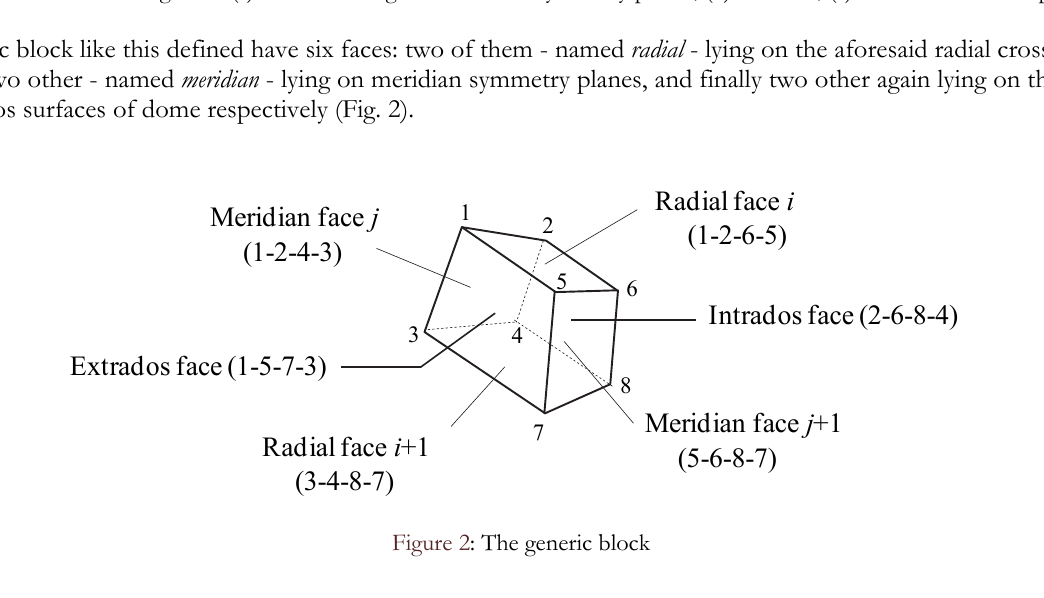
Figure 1: The dome segment. (a) the two contiguous meridian symmetry planes; (b) 3D view; (c) section in the X-Z